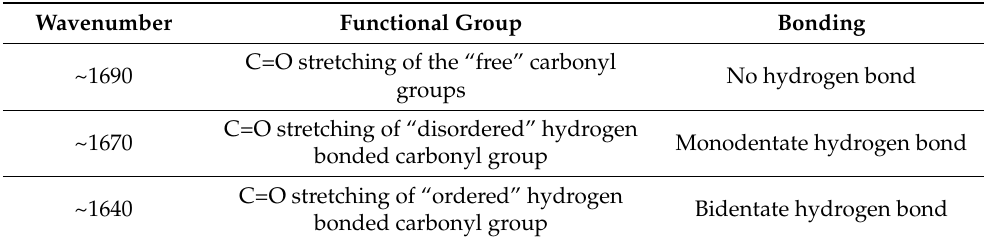
Table 2. Functional group and their representative wavelength